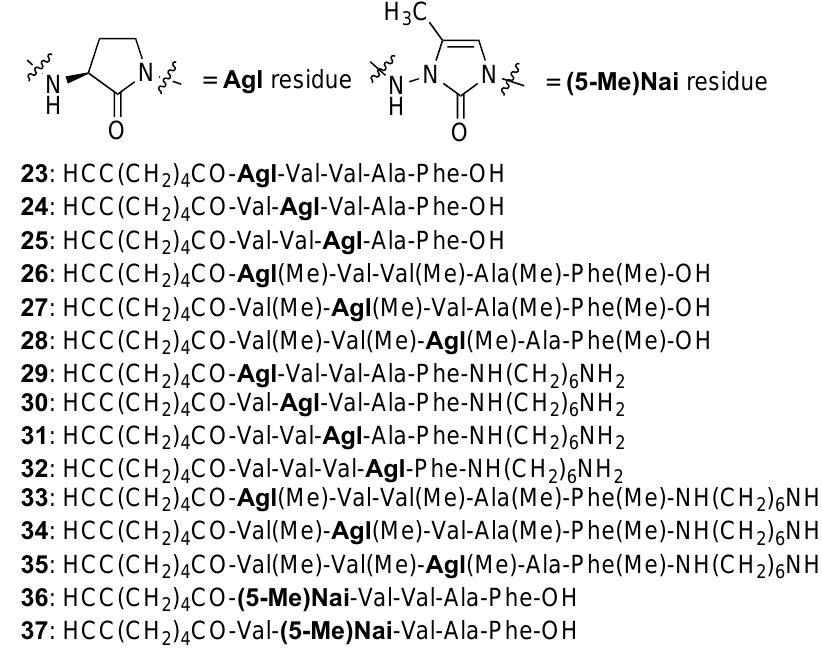
Figure 3. Examination of turn conformation using Agl and Nai residues.